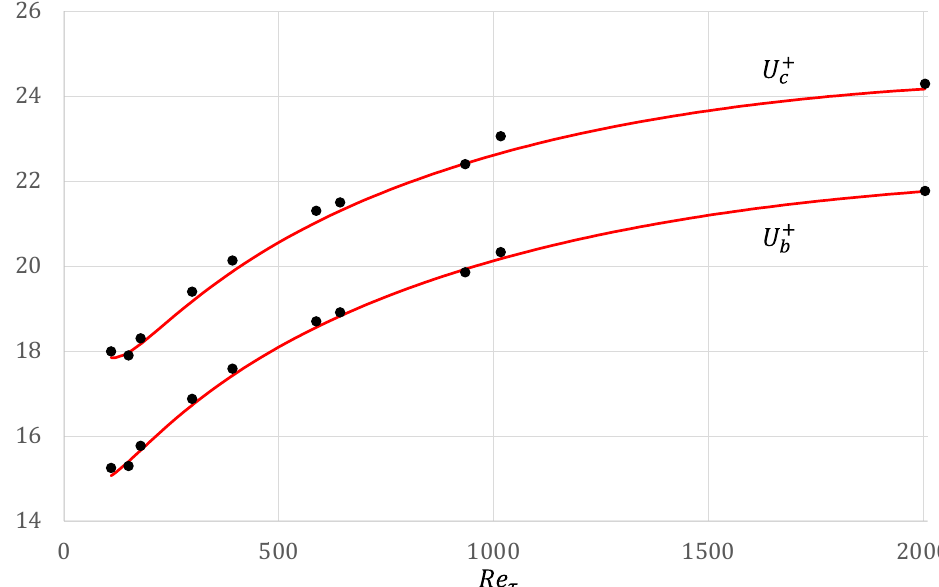
2000 ; • DNS data; and ─ 𝑐𝑐+ 𝑈𝑈